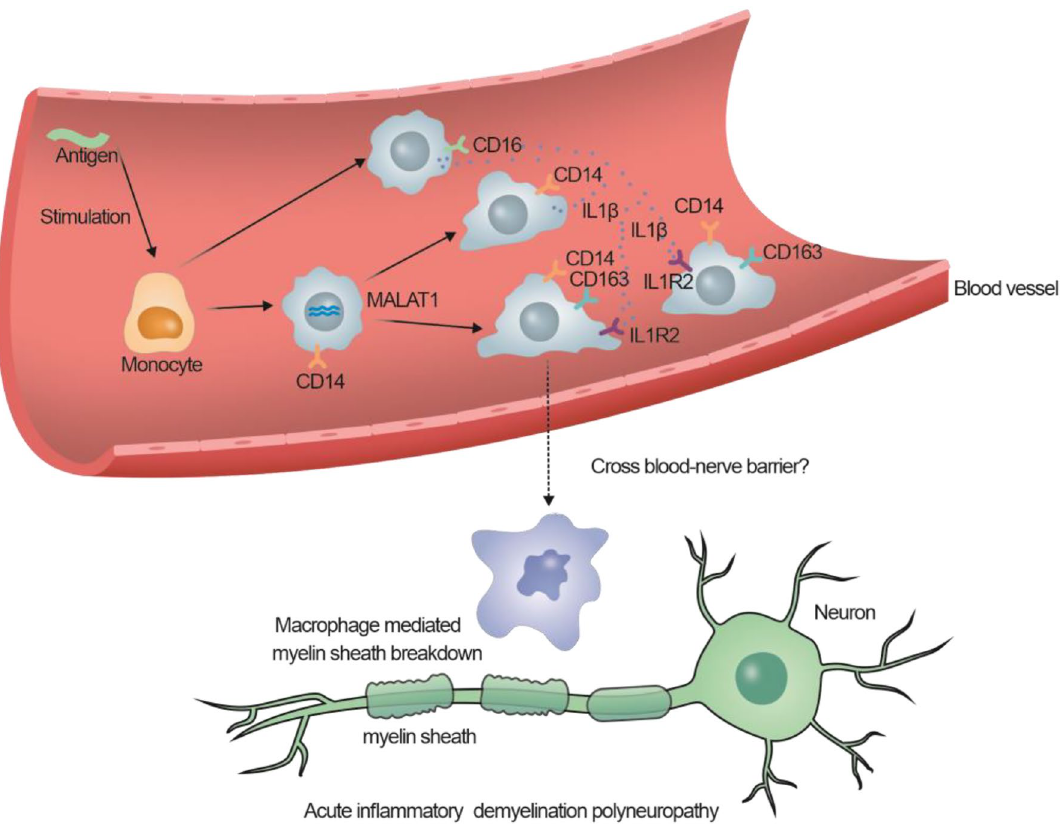
Figure 8. The proportion of CD14 + CD163 + cells in AIDP patients and the potential mechanism of monocytes in